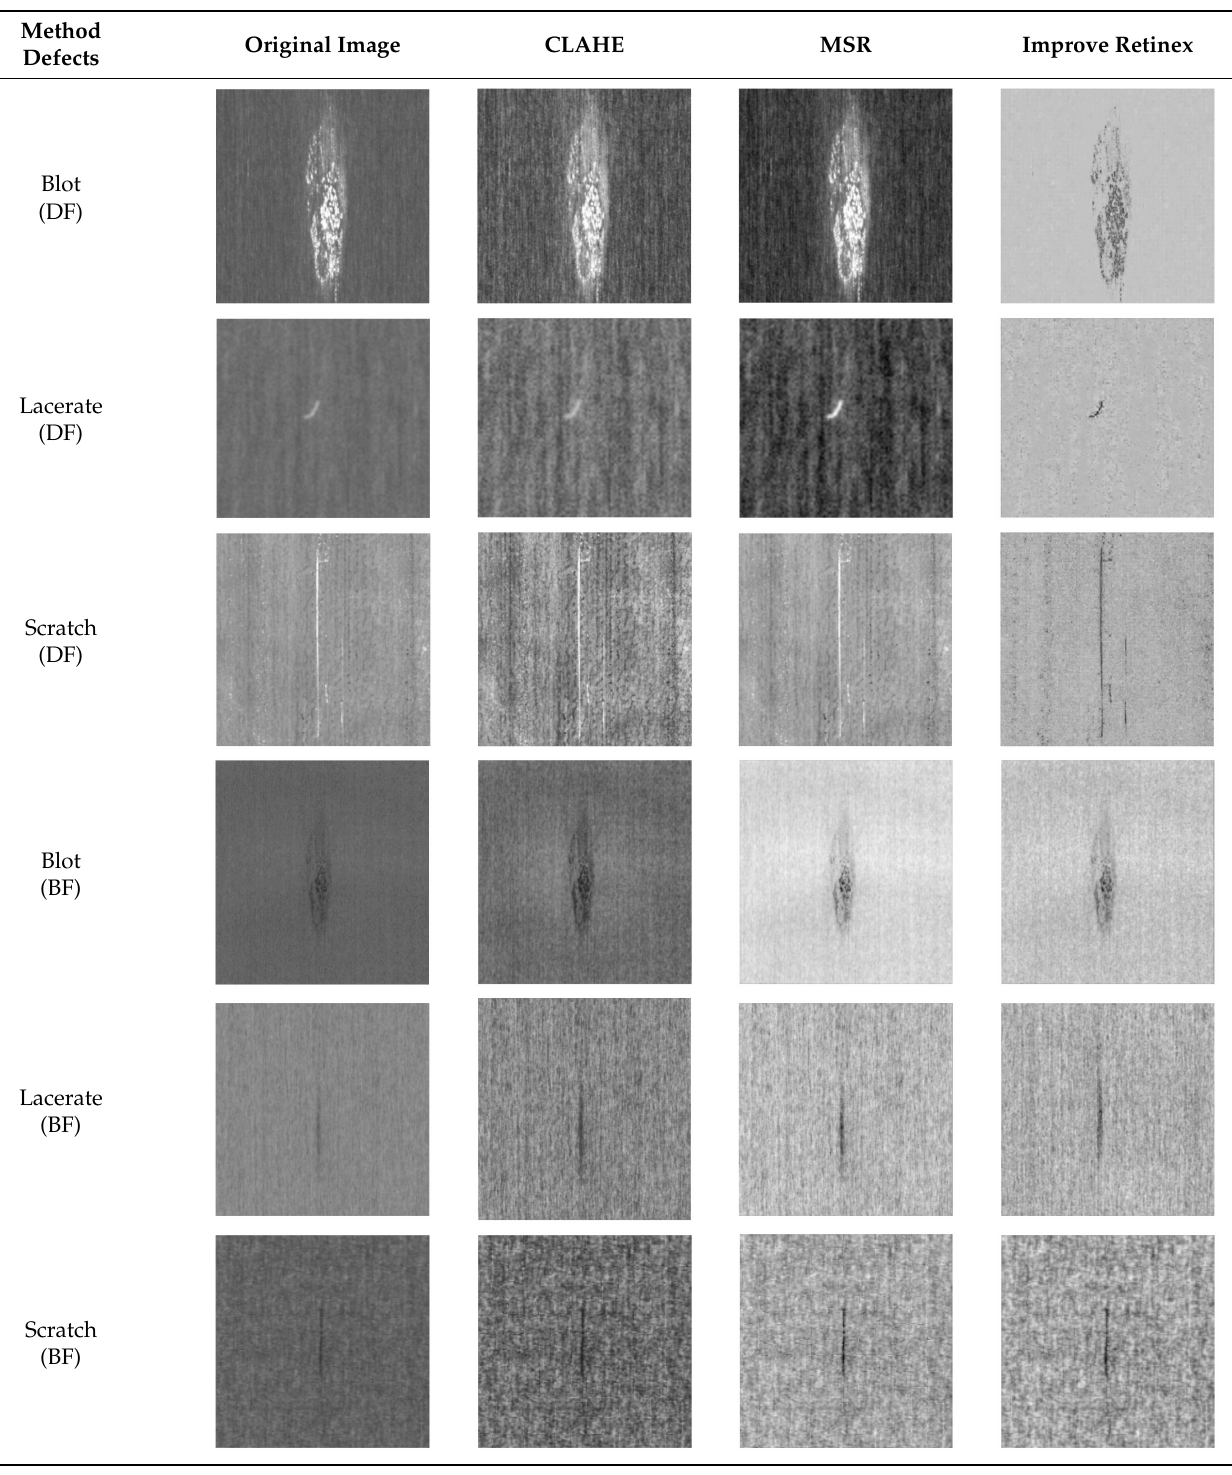
Table 4. Comparison of the enhancement effect of different algorithms on defects in aluminum